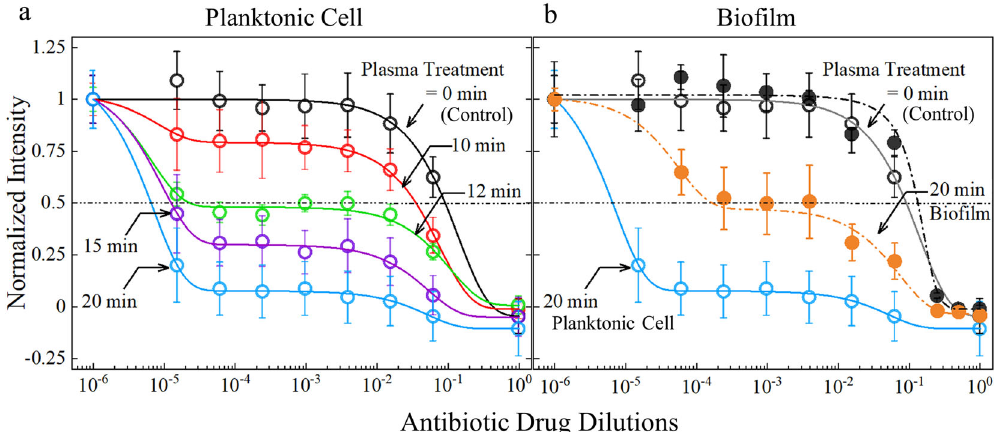
Fig. 6 Antibiotic susceptibility measurements of P. aeruginosa . a Antibiotic drug susceptibility for microplasma-treated planktonic P. aeruginosa, with control data compared to 10, 12, 15, and 20 min of microplasma treatment. b Susceptibility measured for microplasma- treated four-day-old P. aeruginosa bio fi lm. The intensity is the normalized absorbance from the XTT assay. The error bars denote standard deviations from the triplicate samples.